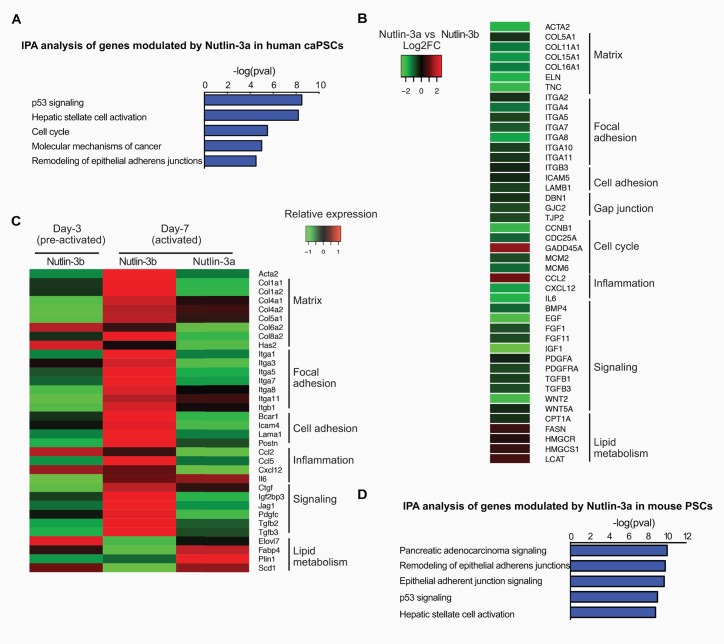
p53 transcriptionally regulates the PSC activation network.(A-B) Four primary human caPSCs were treated for 48h with Nutlin-3a or Nutlin-3b (control) and analyzed by RNA-seq. (A) Ingenuity Pathway Analysis (IPA) was performed on p53 downregulated and upregulated genes from RNA-seq analysis (fold change >1.5 or <0.67, adjusted p <0.05). The 5 most significant canonical pathways are shown and–log(pval) are indicated. (B) Heatmap representing selected genes from the RNA-seq analysis. Data are represented as log2 fold change, Nutlin-3a versus Nutlin-3b. (C-D) Primary mouse PSCs isolated from pancreata of wild-type C57B6/J mice were treated with Nutlin-3a or Nutlin-3b and harvested on day 3 (pre-activated) or on day 7 (activated) of culture. (C) Heatmap shows the relative abundance of selected genes from the RNA-seq analysis of Nutlin-3b treated mPSC (day 3 and 7) and Nutlin-3a treated mPSC (day 7). (D) IPA analysis was performed on p53 downregulated and upregulated genes at day 7 (fold change>1.5 or <0.67, adjpval<0.05). The 5 most significant canonical pathways are shown and -log(pval) are indicated.